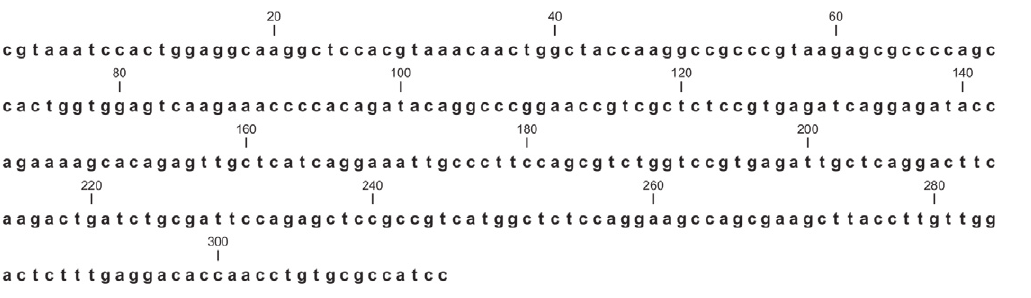
Fig. 1. Histone H3 gene sequence from Crassostrea gigas